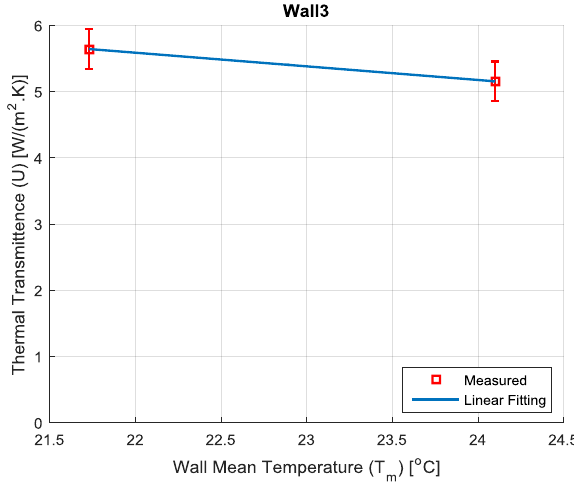
Figure 10. Thermal transmittance of Wall System 3 as a function of the wall mean temperature.